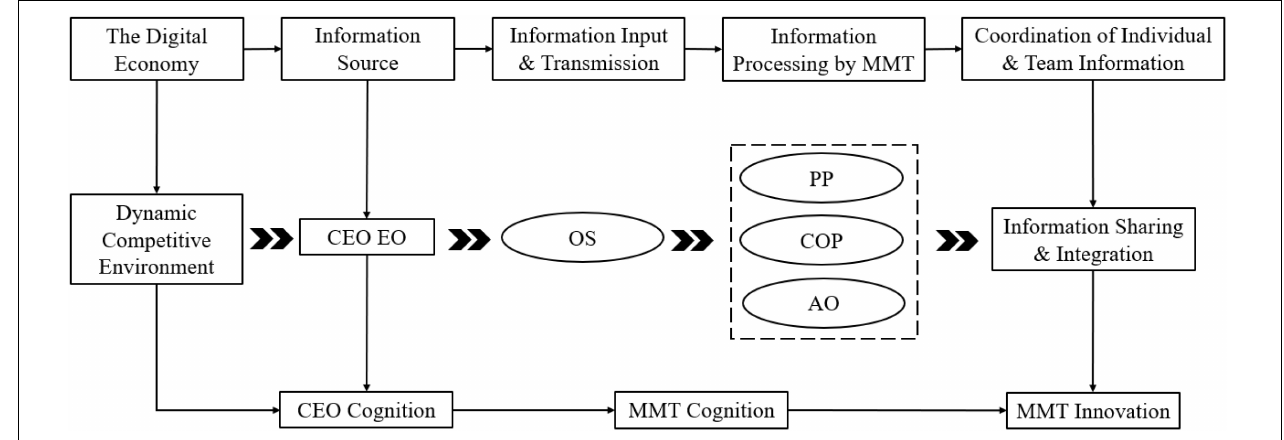
FIGURE 3 | Chief executive officer entrepreneurial orientation vertical penetration and middle management team innovativeness. CEO EO, CEO Entrepreneurship Orientation; OS, Organisational Structure; COP, Confidence in the Organisation’s Prospects; AO, Achievement Orientation; PP, Performance